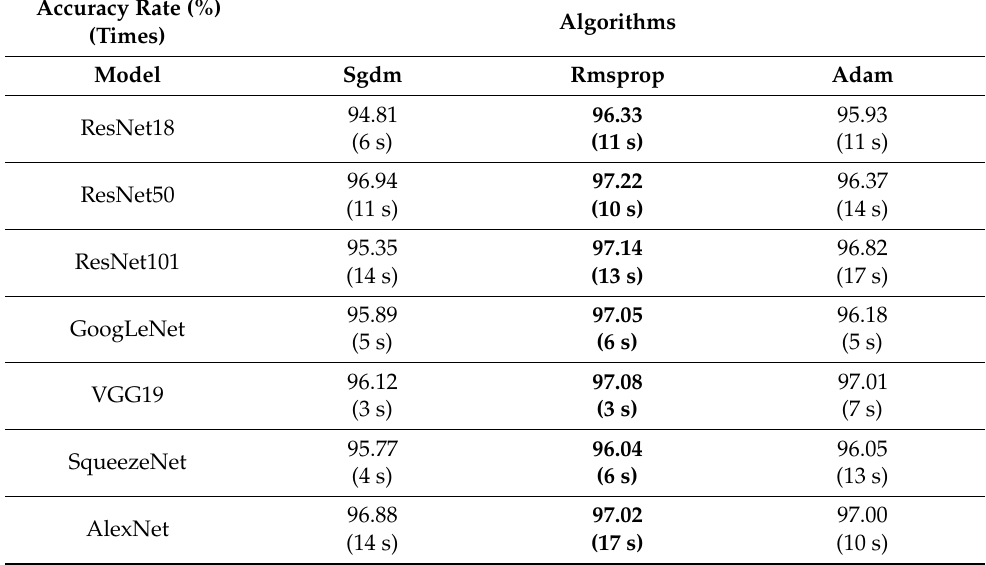
Table 5. Experiment I: the best results of nine tissue classes (CRC-VAL-HE-7K).